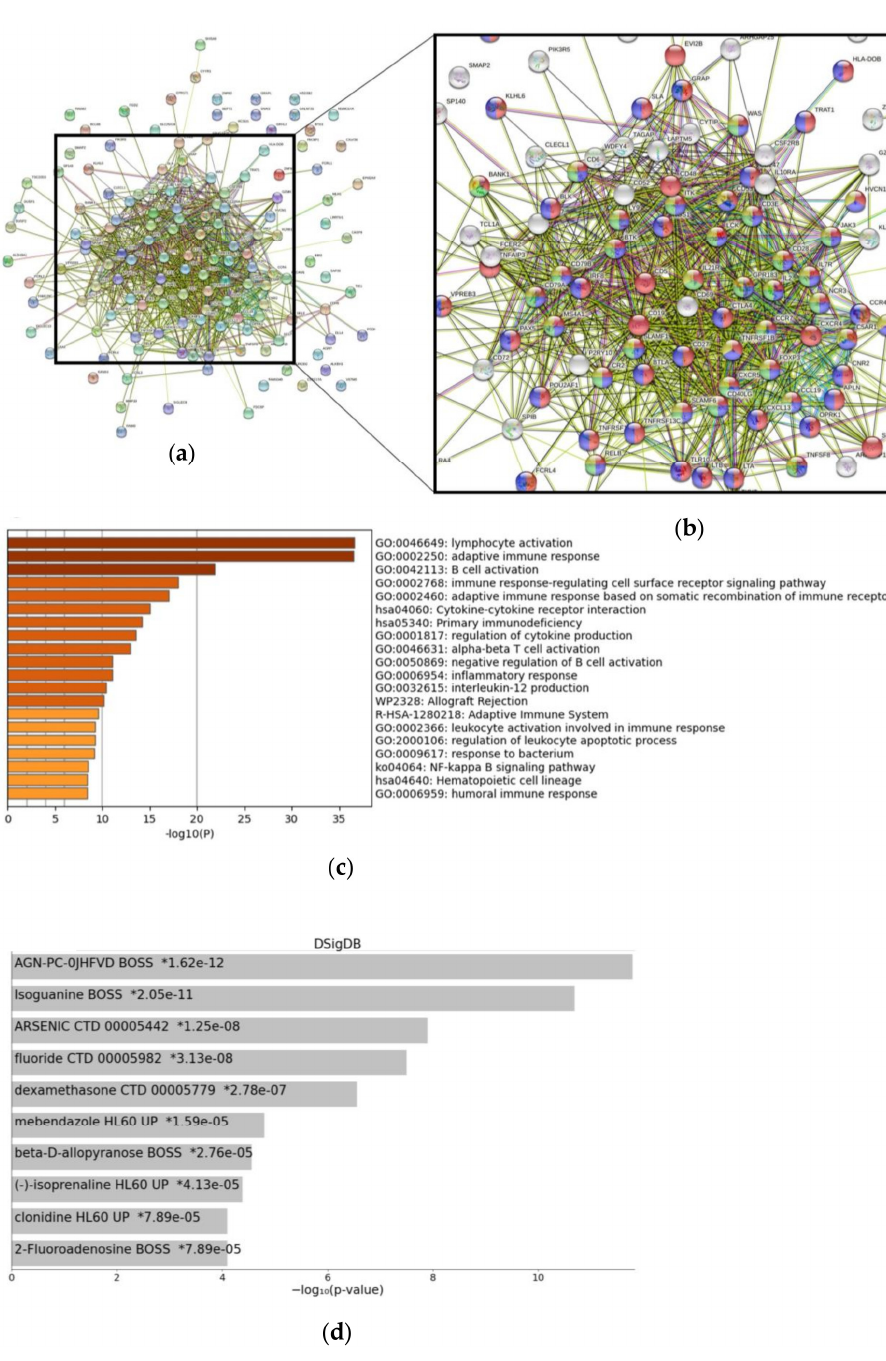
Figure 1. Gene networks, functions, and drug-induced gene signatures associated with CXCR4 expression. ( a ) StringDB network analysis for 141 genes included. StringDB network focused on ( b ) the main complex of the network with marked biological processes “immune system process” (GO:0002376—red), “immune response” (GO:0006955—blue), “lymphocyte activation” (GO:0046649—green), and “leukocyte activation” (GO:0045321—yellow). ( c ) Bar-graph summary of significantly enriched terms for genes overexpressed in CXCR4 high-expressing samples as provided by Metascape analysis. ( d ) Drug-induced signatures (predicted via Drug Signatures Database) significantly related to CXCR4 expression within the Random Forest learning approach. Drug Signatures Database was accessed via the EnrichR web